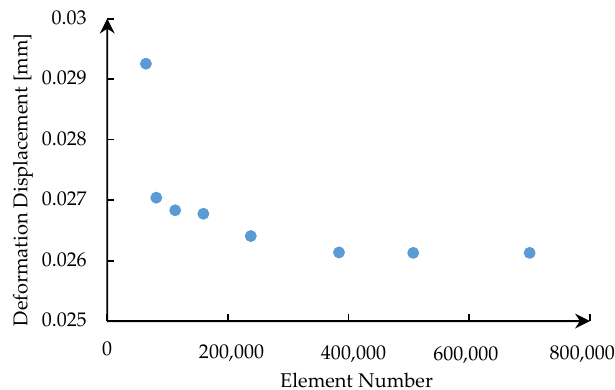
Figure 4. Deformation displacements from the FE model for different element numbers.